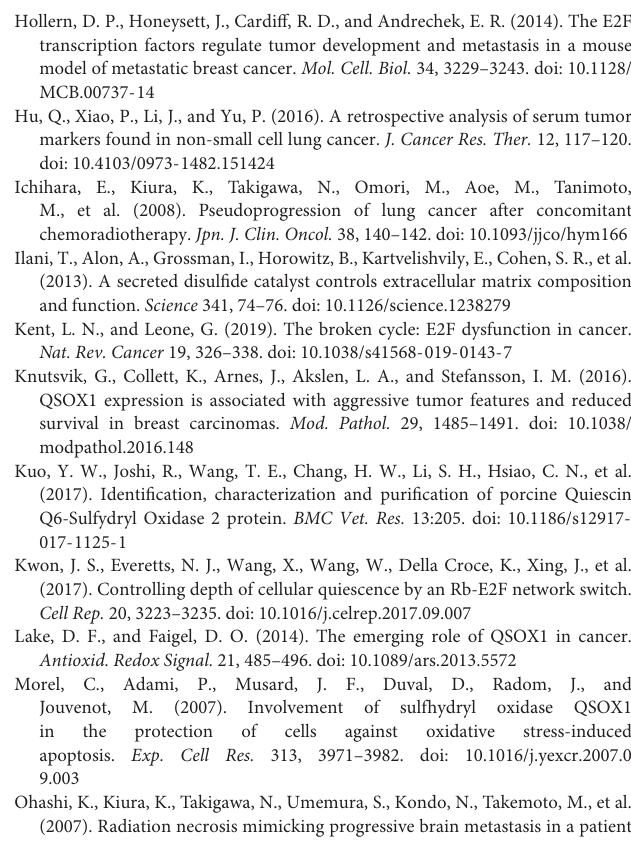
Supplementary Figure 1 | Overexpression of QSOX2 in malignancies correlates with prognosis. (A) The expression of QSOX2 in non-tumor ( n = 707) and tumor ( n = 10,323) tissue samples, according to the Pan-TCGA dataset. (B) The association between the expression level of QSOX2 and patient survival, according to overall survival time data in the Pan-TCGA dataset. Supplementary Figure 2 | The cisplatin treated NCI-H1299-xenograft mouse model and clinical samples. (A) The graph shows xenograft growth with or without cisplatin treatment. (B) The boxplot compares the volumes of xenografts treated with or without cisplatin. (C) The sera from 6 patients were diluted 15 times and subjected to WB analysis for QSOX2 expression. Reversible Ponceau S staining was applied to ensure equal loading of the gels. * P < 0.05. Supplementary Figure 3 | Kyoto Encyclopedia of Genes and Genomes pathway enrichment analysis of QSOX2 -related genes. (A) KEGG enrichment bubble chart. Negative log base 10 FDR values from the pathway enrichment analysis were plotted. Dark blue: FDR < 0.05; light blue: FDR ≥ 0.05. (B–D) NSCLC cells transfected with the indicated plasmids, and the cell numbers were measured at the indicated time points using flow cytometry. The data shown represent the mean ± SD, n = 3, ∗∗ P <